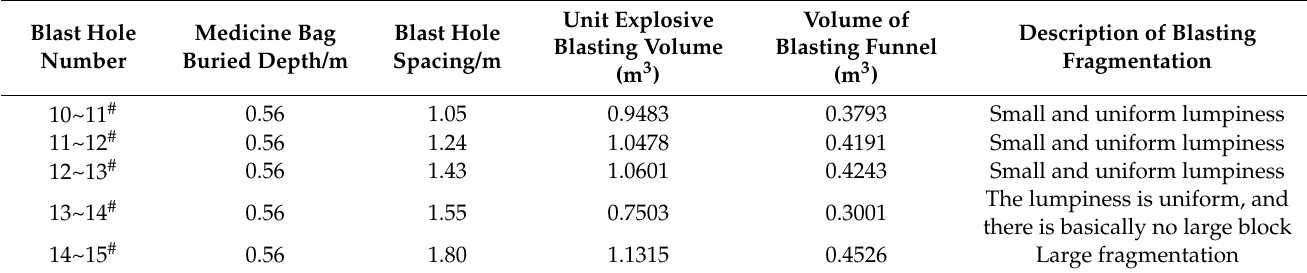
Table 4. Test results of multi hole blasting funnel with variable hole spacing.